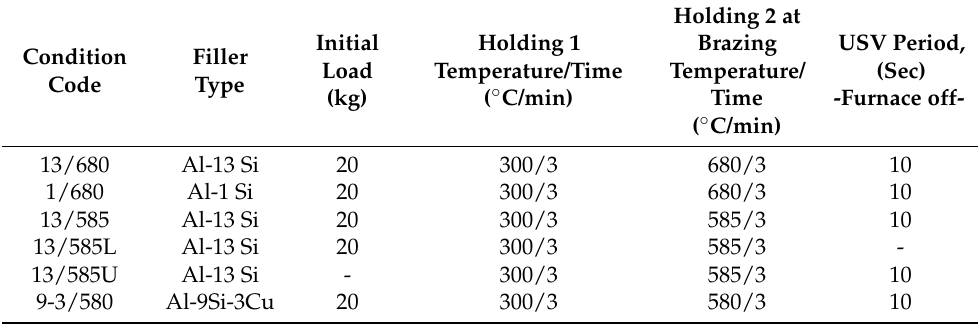
Figure 5. Brazing cycle using the parameters presented in Table 2. The diagram shows a sketch of the observed load changes due to expansion. After application of the primary load of 20 kg, the load increase due to the expansion was removed after passing the solidus temperature of the filler at the point N2 (explained in Section 3.2) to prevent any displacement of the filler before reaching the USV application point. The temperature-time cycle represents the cycle applied by the furnace controller, actual recorded cycles will be presented later in this work. All holding times started − 5 ◦ C to the required temperature. The brazed joint was cooled inside the furnace. During cooling, furnace sides were removed at 300 ◦ C. The sample was removed from the furnace after the cooling temperature passed 250 ◦ C. Table 2. Brazing trials parameters which were used in the brazing cycle presented in Figure